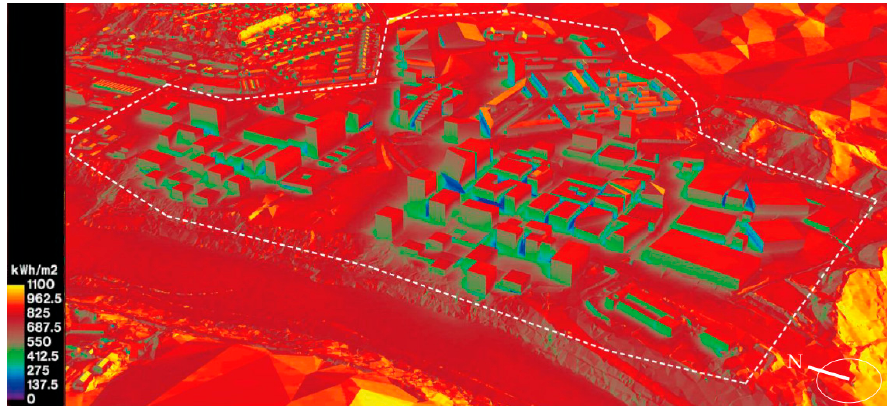
Figure 10. Example of the annual irradiation analysis for feasibility study I. Table 12 . Seasonal irradiation analyses in the existing situation and in the feasibility studies.